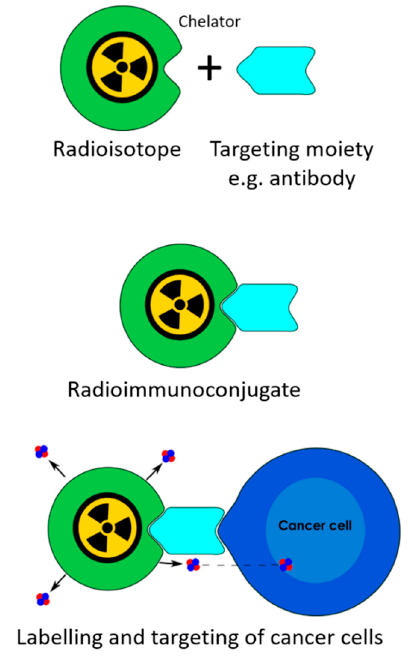
Figure 1. The principles of radioimmunotherapy.